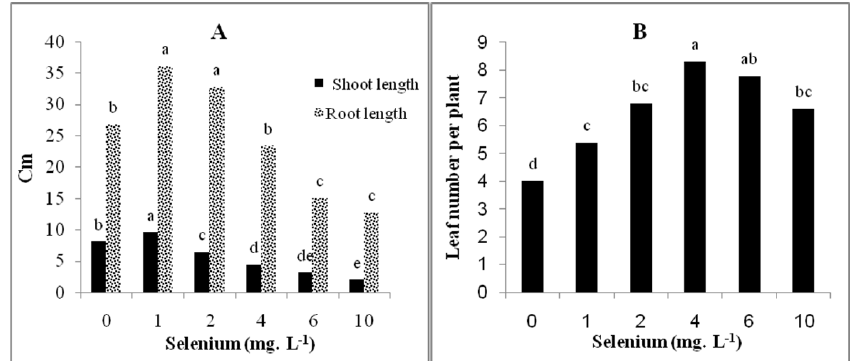
Fig. 1. Effect of selenium supplementation on shoot and root length (A) and leaf number per plant (B) of spinach plants